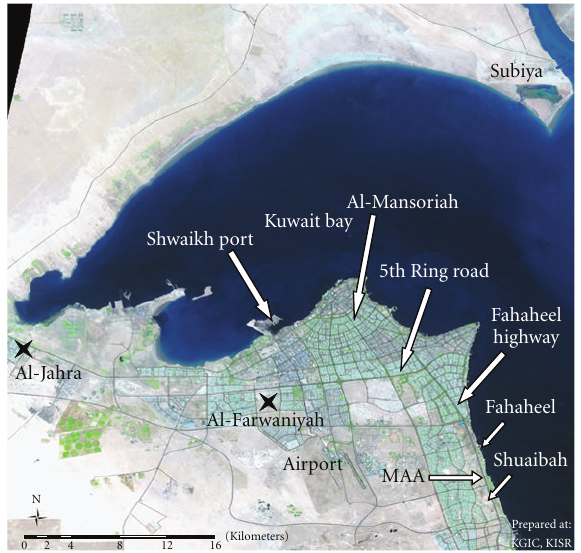
Figure 1: Urban Kuwait map showing main locations in the stat. Image courtesy of satellite archives at the Kuwait Institute of Scientific